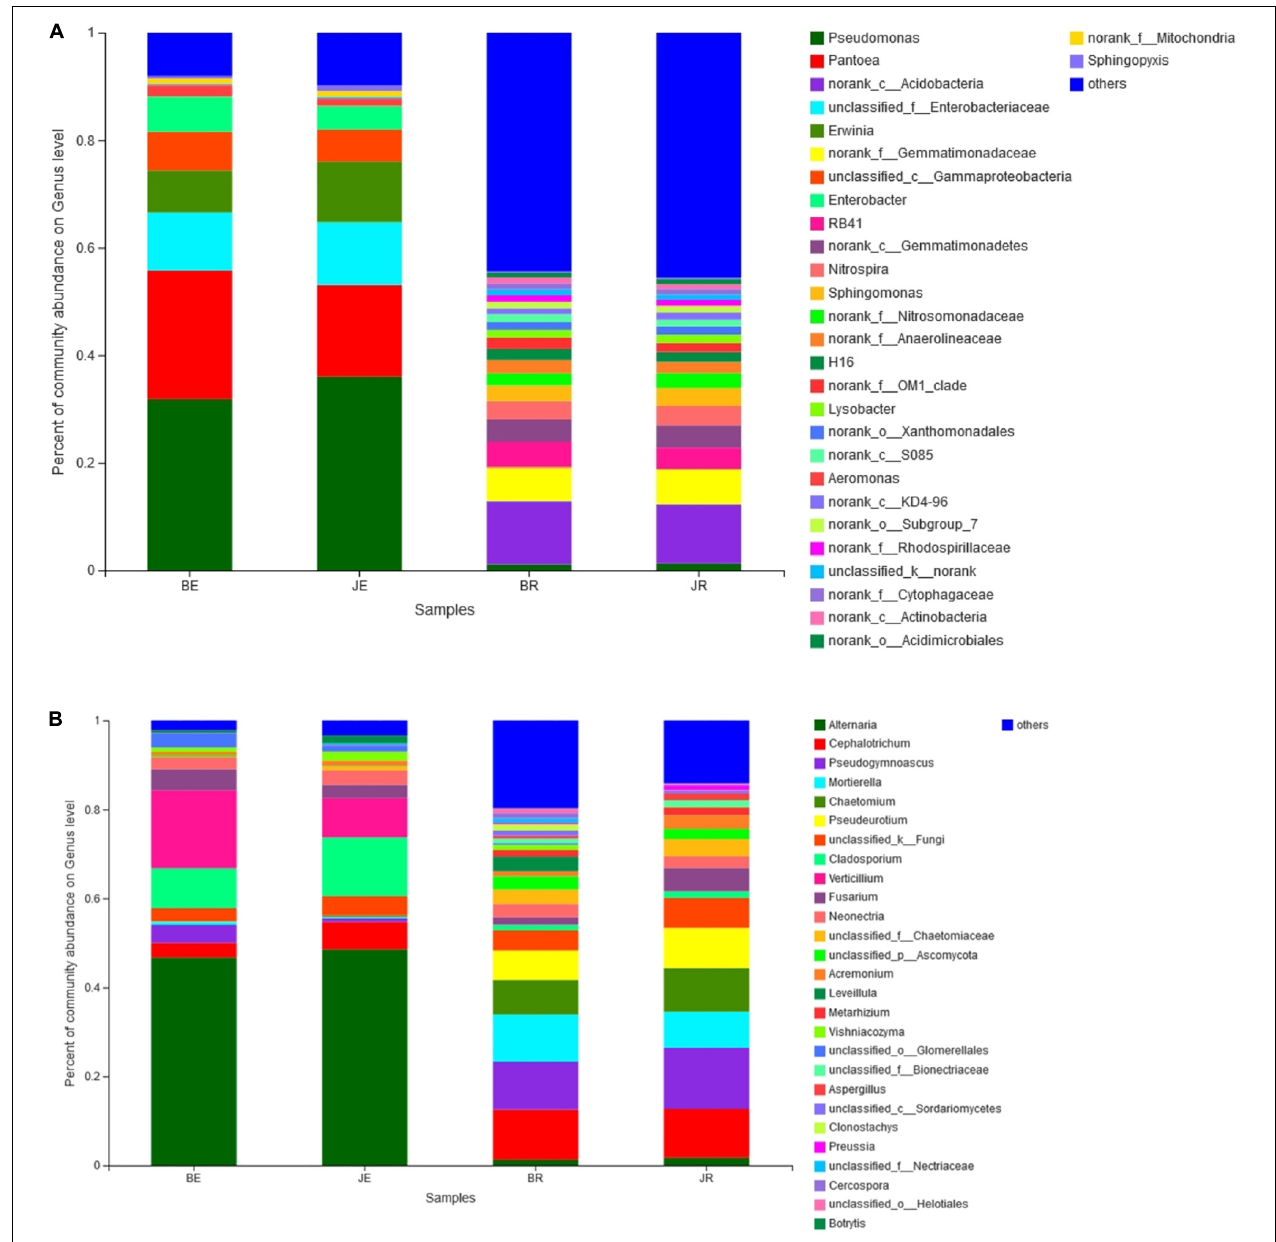
FIGURE 4 | Bacteria (A) and Fungal (B) composition of the different communities at the genera level. Relative read abundance of different bacterial phyla within the different communities. Phyla, classes, and genera making up less than 1% of total composition in all three libraries were classified as